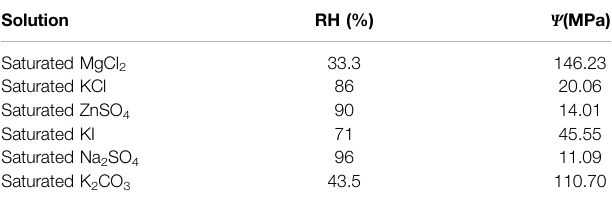
TABLE 2 | The total suction and RH of saturated solution (15 °